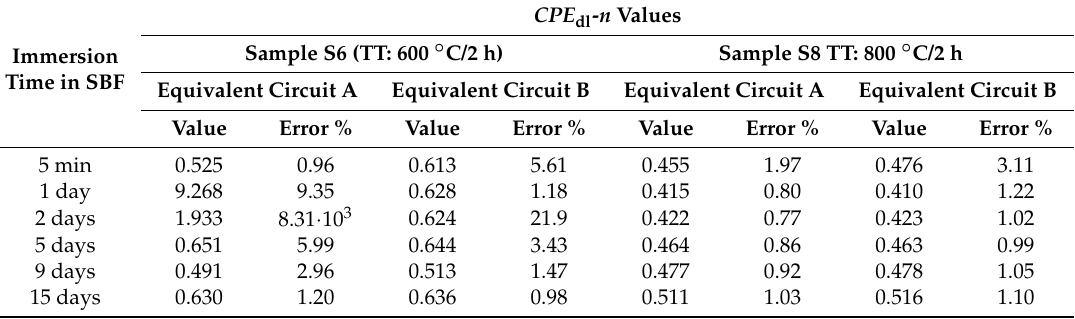
Table 6. CPE dl - n values and % of relative error obtained with the equivalent circuits A and B applying CNLS fits from the ZView software on experimental impedance plots of samples S6 (600 ◦ C/2 h) and S8 (800 ◦ C/2 h), for variable immersion time in